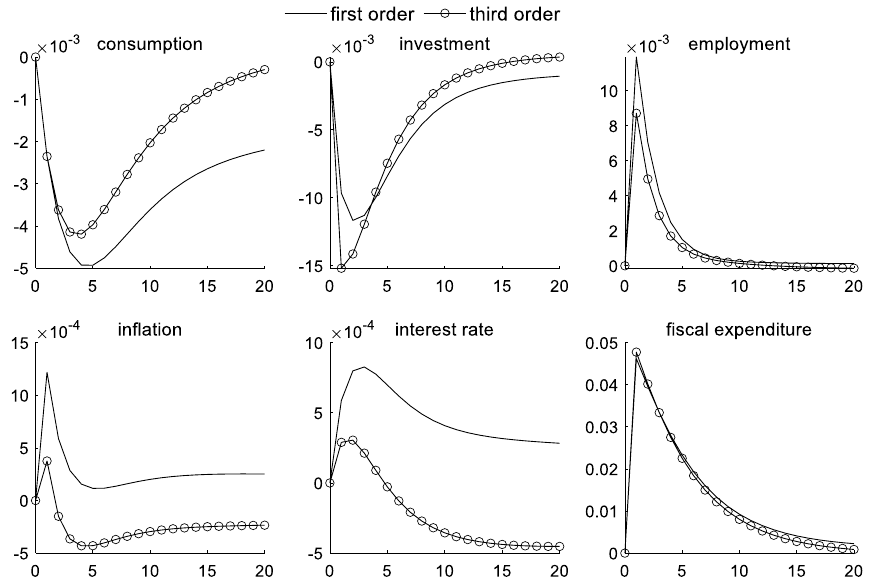
Fig. 2 Macroeconomic effects of fiscal policy shocks under uncertainty